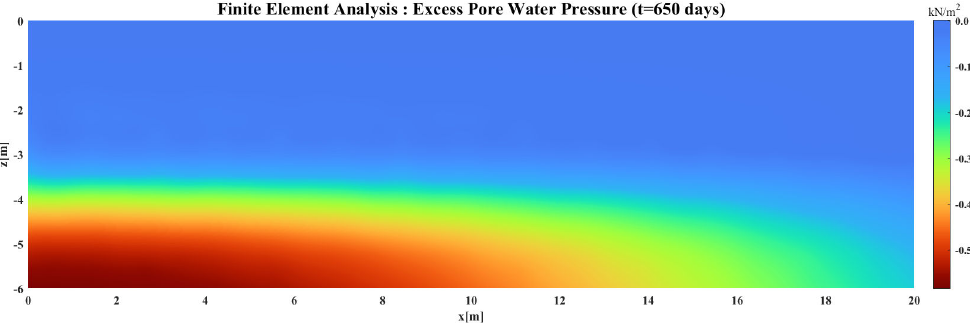
Figure 16. Color map of excess pore water pressure based on the finite element analysis.